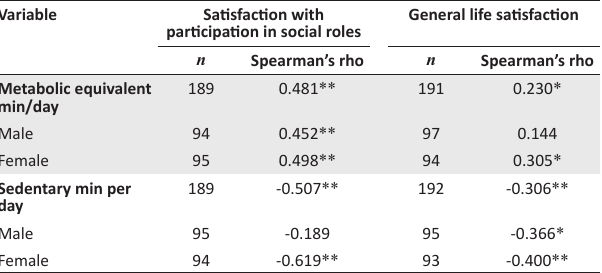
TABLE 5: Correlations between physical activity and life satisfaction, further stratified by gender. Variable Satisfaction with participation in social roles